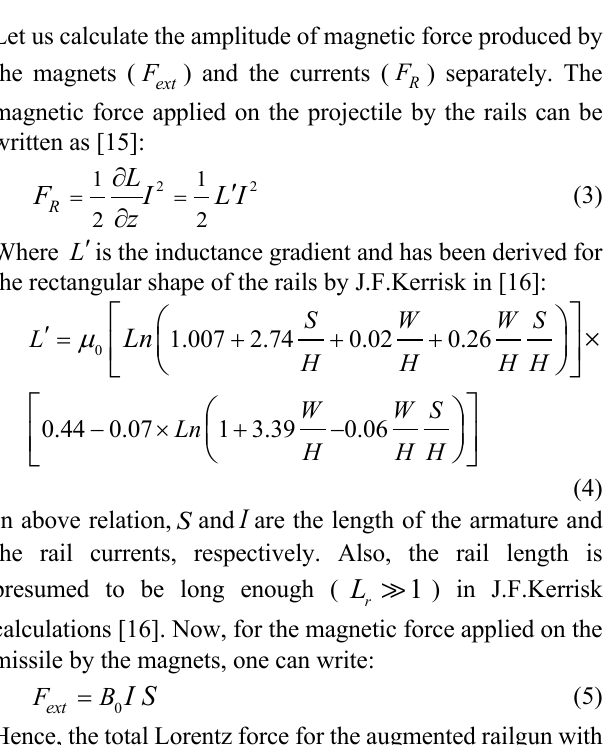
Figure 2: The 3D schematic of augmented railgun with two